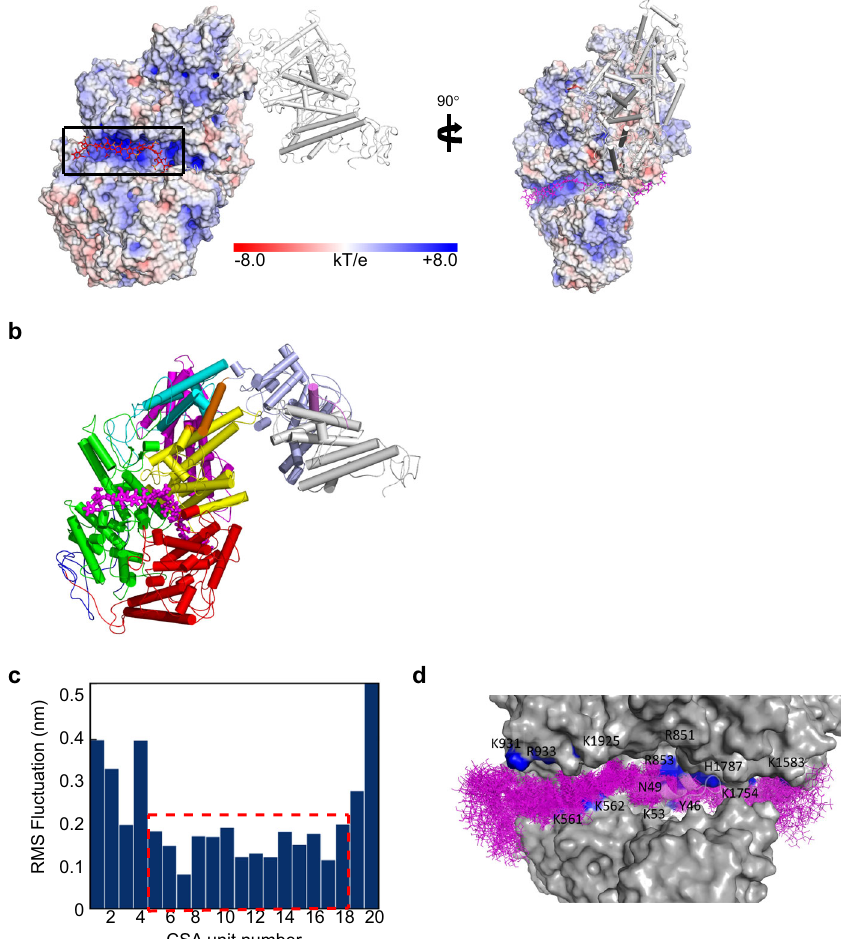
Fig. 4 Docking model of VAR2CSA in complex with a CS 20-mer. a The docking structure of VAR2CSA in complex with CS 20-mer. The electrostatic potential surfaces of VAR2CSA with the minimal binding region and binding groove, which is highlighted by a black box. A surface potential (kT/e) color bar is shown. The CS molecule is represented by sticks in red. The DBL5/6 domains are shown in white cartoon. The right panel shows the structure turned 90°. b Docking structure of VAR2CSA shown as cartoon with domains colored as in Fig. 1d. The CS molecule is shown as sticks in magenta. c Conformational fl exibility of CS ligand in the binding groove of VAR2CSA. Boxed area shows the core part of the CS chain with relatively low RMSF values, corresponding to roughly seven disaccharide units. d Binding groove of VAR2CSA with an ensemble of CS 20-mer with 70 conformers sampled in a 70 ns MD simulation with an interval of 1 ns. CS interacting residues from VAR2CSA are labeled with residue